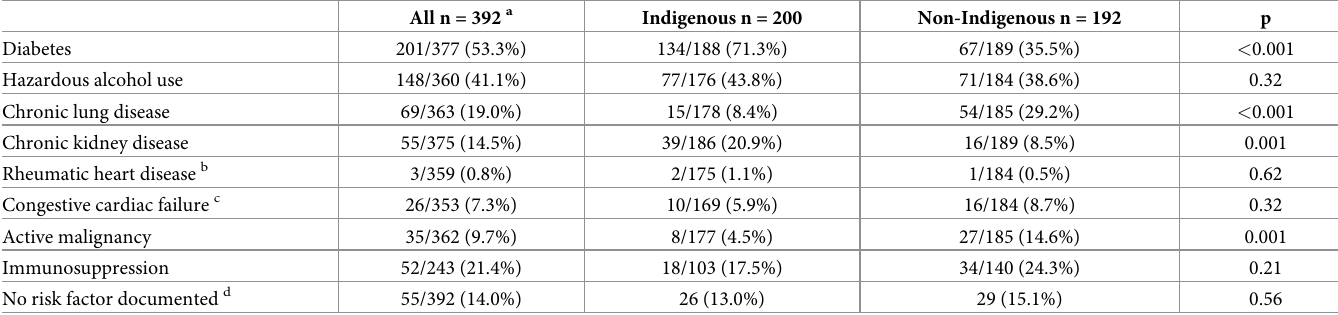
Table 1. Proportion of the FNQ cohort with the different predisposing risk factors for melioidosis, stratified by Indigenous status.